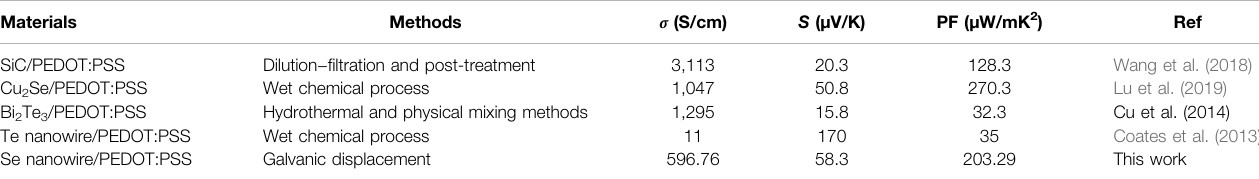
TABLE 1 | Comparison of the characteristics properties of organic/inorganic composite thermoelectric. Materials